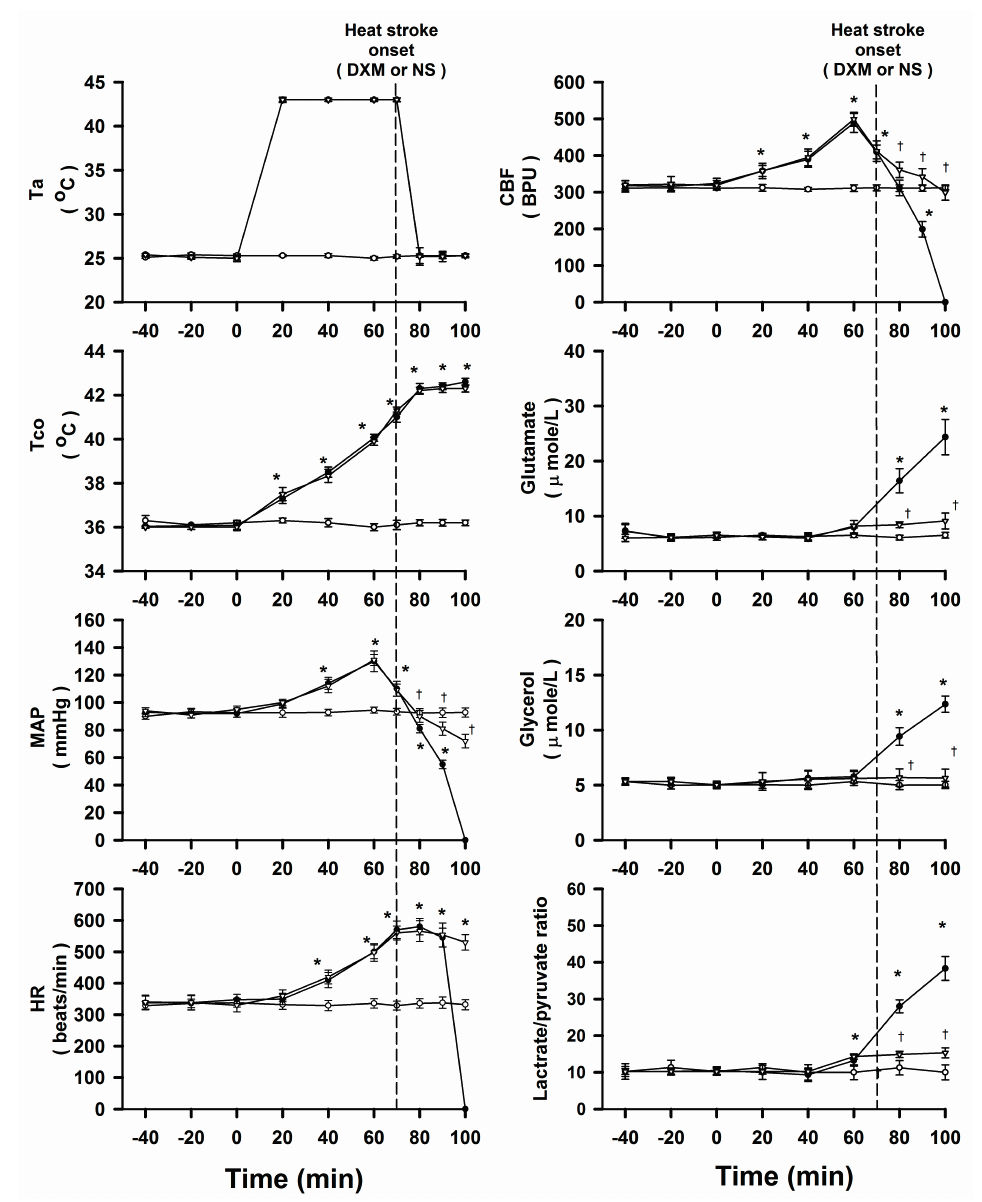
Figure 1. Effects of heat exposure (43 °C) on colonic temperature (Tco), MAP, heart rate (HR), CBF and the extracellular concentrations of glutamate, glycerol, and lactate/pyruvate ratio of the corpus striatum in normothermic control rats (open circles), 0.9% NaCl solution-treated (filled circles, 8 mk/kg b.w., i.v.) or DXM-treated rats (open triangles). The dotted line indicates time of heat stroke onset and drug injection. * p < 0.05, compared with normothermic control rats (ANOVA followed by Duncan’s test); † p < 0.05, compared with saline-treated rats (ANOVA followed by Duncan’s